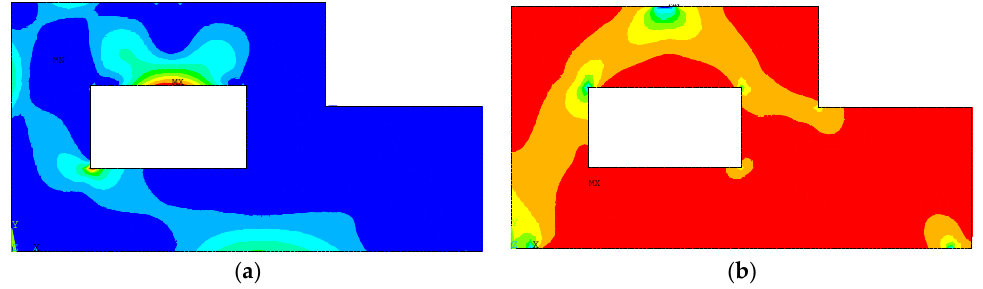
Figure 2. FE analysis results of Group A irregular concrete deep beams: ( a ) Principal tensile stress; ( b ) Principal compressive stress.